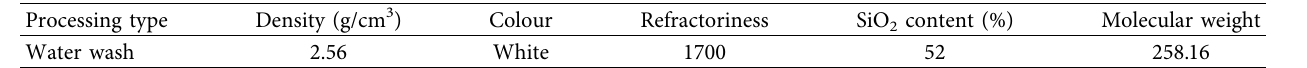
Figure 1: Schematic diagram of the test device. Table 1: Related physical parameters of kaolin.